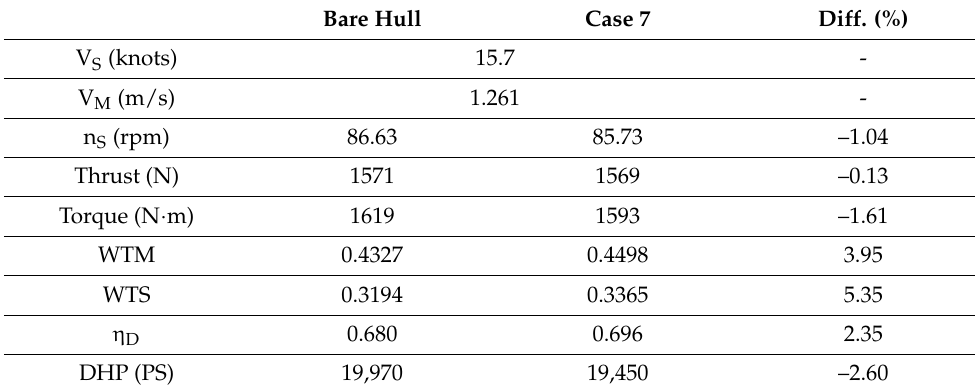
Table 14. Results of the self-propulsion model test.